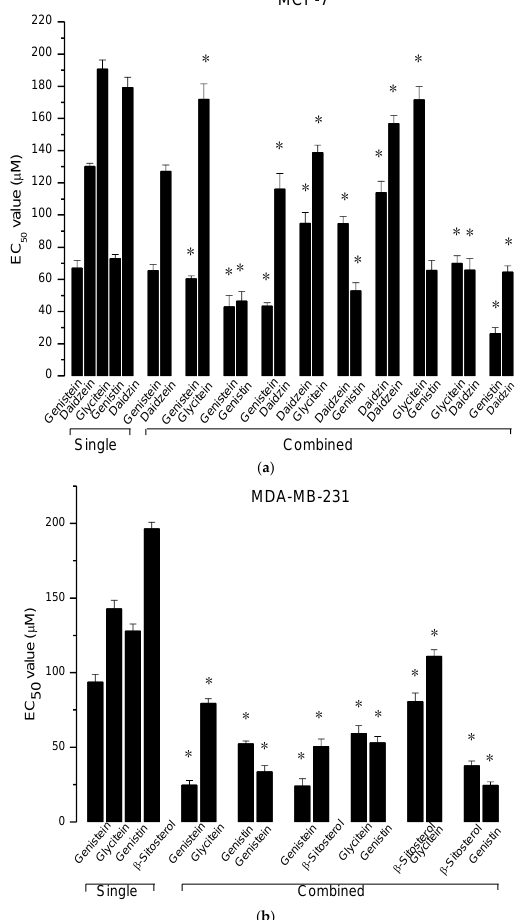
Figure 2. EC 50 values of bioactive anticarcinogens by single or two-way combination treatment in MCF-7 ( a ) and MDA-MB-231 ( b ) human cancer cells. Data are presented as mean ± SD. * Indicates a significant difference compared to the EC 50 value of single treatment ( p < 0.05).